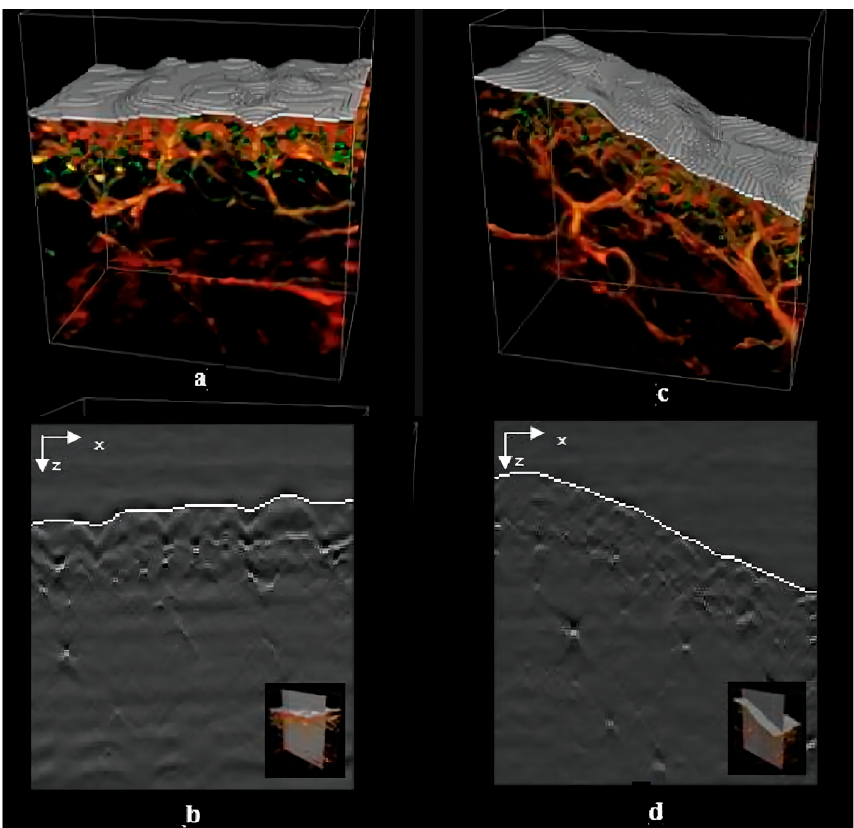
Figure 10. Examples of successful skin segmentation from RSOM data. ( a , c ) 3D volumes including the estimated skin layer. ( b , d ) 2D slices of the volumes in panels ( a ) and ( c ), respectively, including the estimated skin contour [88]. Copyright 2020 IEEE.